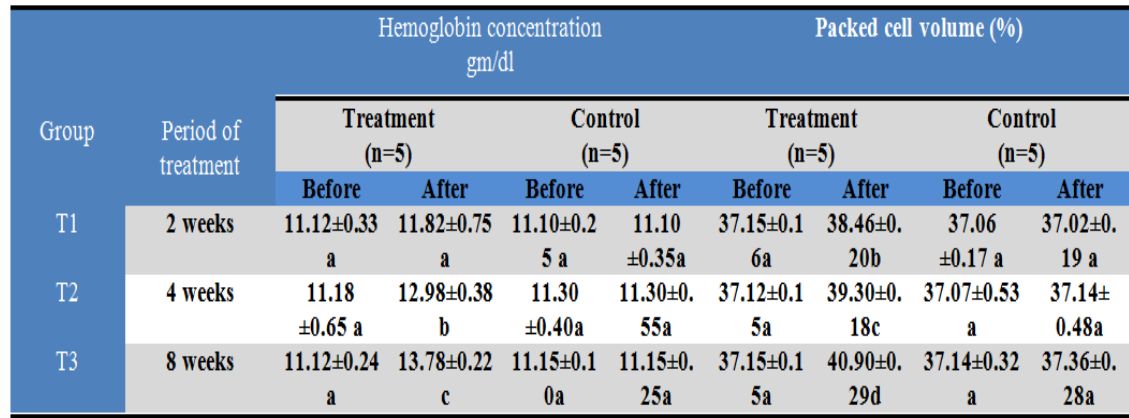
Table 7: Effect of orally administering a double dose (9.6 mg/kg/day) of Citrullus colocynthis on hemoglobin concentration and packed cell volume of rabbits